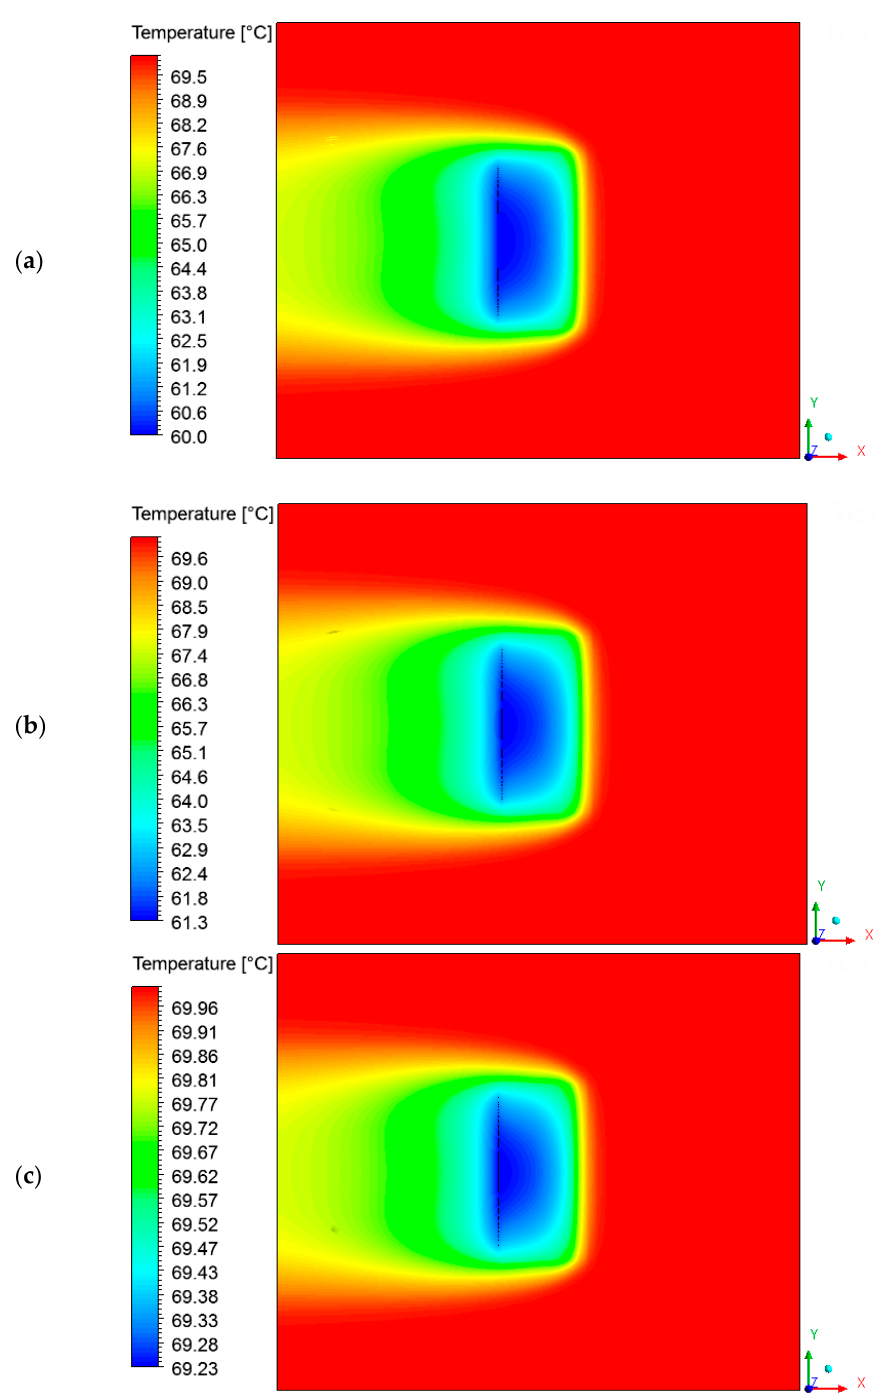
Figure 12. Temperature fields of the air in a plane XY (Z = 0.197 m) at different moments of drying: